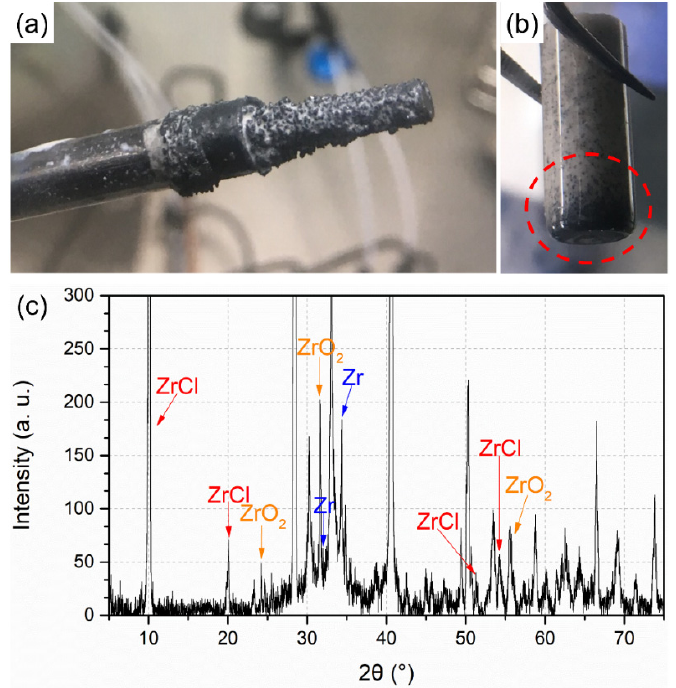
Figure 5. ( a ) Cathode deposit in test 3; ( b ) salt ingot obtained from the cathode basket in test 3; ( c ) XRD pattern of the cathode deposit.